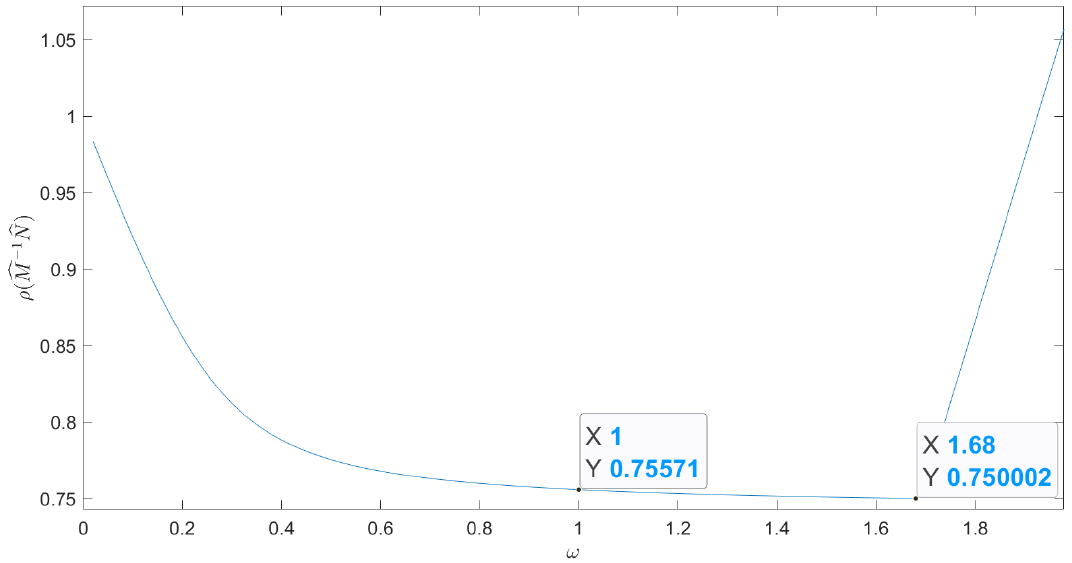
Figure 4. The spectral radius of (cid:98) M − 1 (cid:98) N for M i , i = 7,8. We let A = 400 I 1000 + T 20 ⊗ I 50 + I 50 ⊗ T 20 , and B = 380 I 1000 + 2 I 50 ⊗ T 20 , and used the PIM algorithm with M 9 = 0.5 D − L , M 10 = 1.5 D − U , and t k = 2, the MPIM algorithm with M 9 = 0.5 D − L , M 10 = 1.5 D − U , t k = 2, and ω = 0.6, the SOR algorithm with ω = 0.6, the M-SSOR algorithm with γ = ω = 0.6, and the M-SOR algorithm with γ = ω = 0.6 to solve AVE (1), as shown in Figure 5.